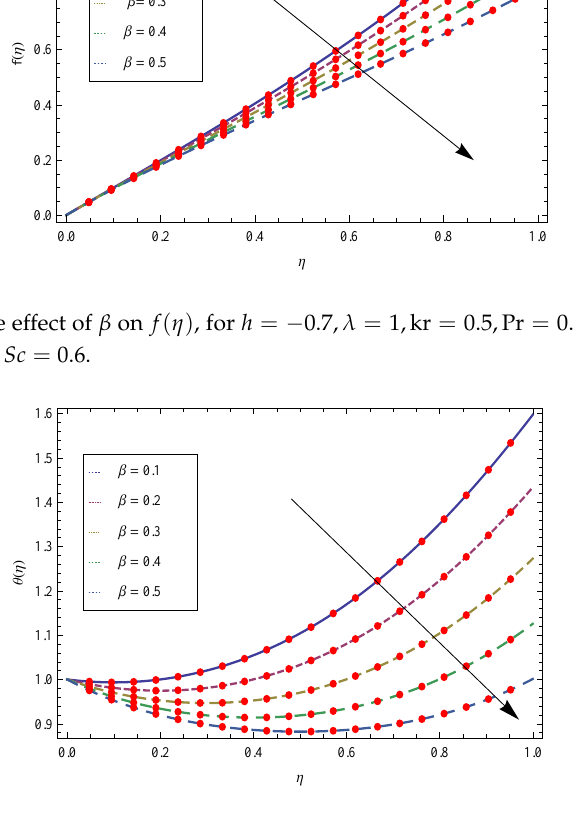
Figure 24. The effect of β on θ ( η ) , for h = − 0.7, λ = 1, S = 0.5,kr = 0.5,Ec = 0.5,Nb = 0.5,Nt = 0.6 and Sc =